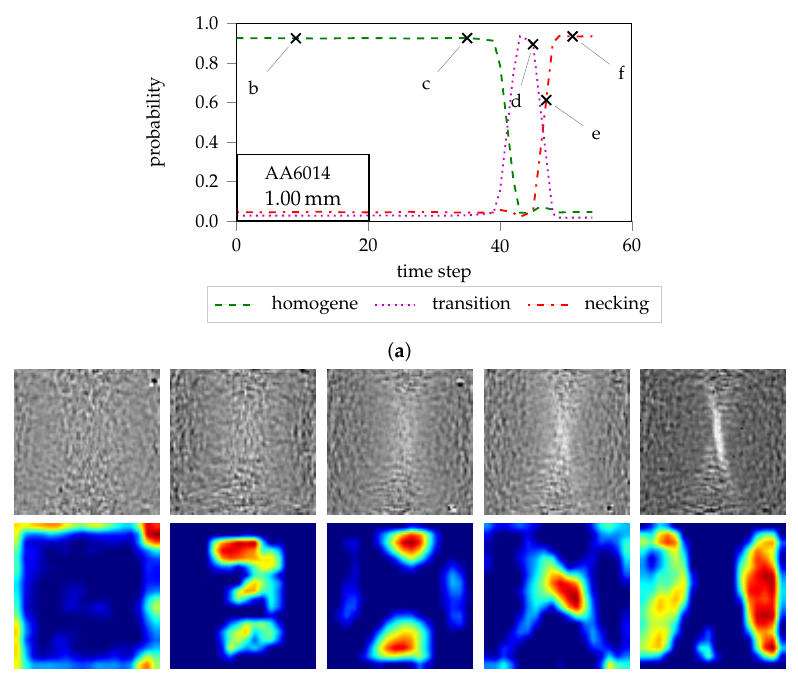
Figure 1. The temporal progression of cluster memberships for one forming sequence with strain difference images and corresponding classification heat maps at different time-points: ( a ) Cluster membership progression for AA6014-S050-1 with three different forming phases according to the work in [26]. ( b – f ) illustrate the difference images and class activations of the homogeneous forming phase at time-point 10 and 36, the transition phase at time-point 46, the necking phase at time-point 48, and the end of the forming process or necking phase at time-point